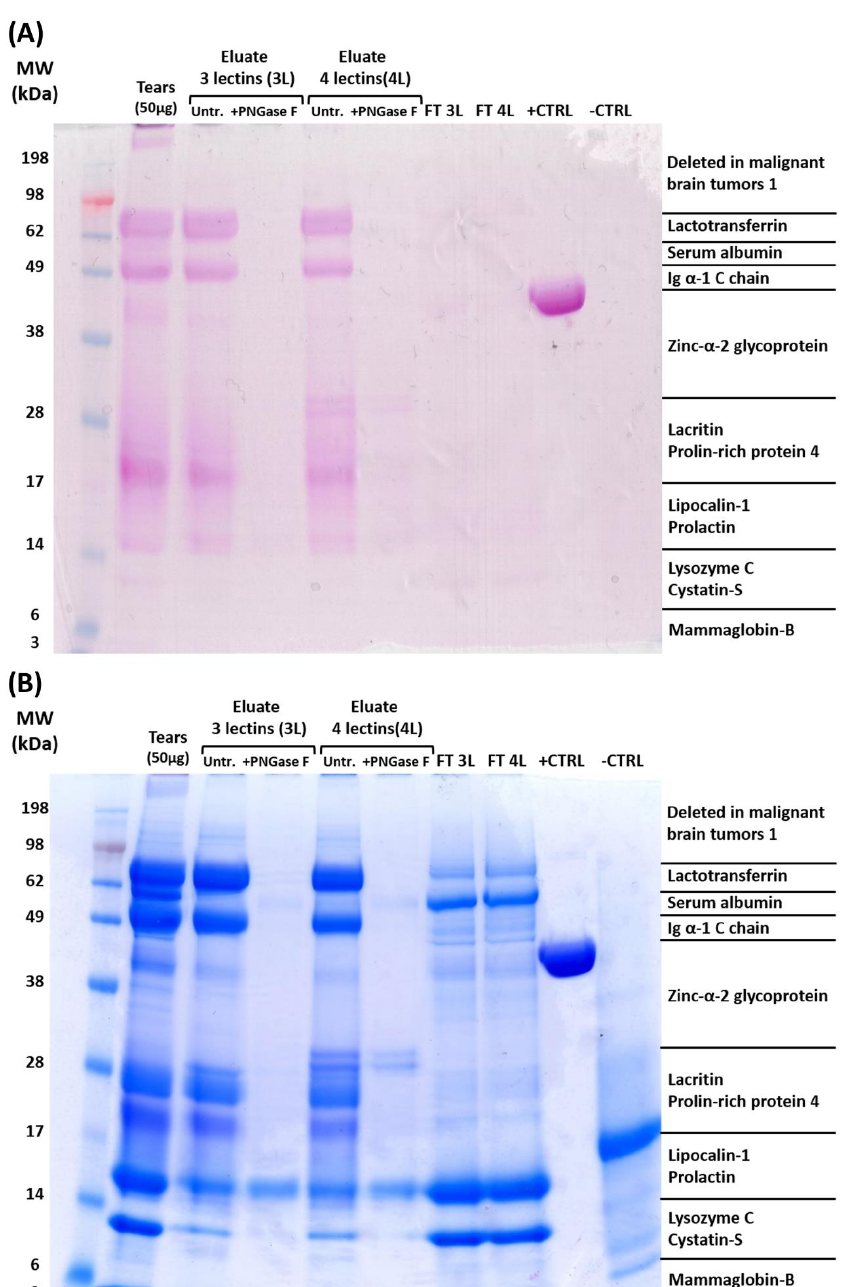
Figure 3. The 1D gel electrophoresis and glycoprotein/Coomassie staining of enriched glycoproteins from human tear sample pools. Both images illustrate the eluate as well as the flow-through (FT) fractions of the 3L multi-lectin column (combination of ConA, JAC, and WGA) and the 4L multi- lectin column system (combination of ConA, JAC, WGA, and UEA I). Prior to affinity enrichment, the tear sample pools were partially pre-treated with PNGase F to release the N-glycans from the glycoproteins. An untreated tear sample pool (50 µ g) was also included to match the enriched glycoprotein spots with the native tear film proteome. In addition, a glycosylated protein stan- dard (horseradish peroxidase, +CTRL), as well as a non-glycosylated protein standard (soybean trypsin inhibitor, -CTRL), were either included as a positive or negative control in this experiment. ( A ) Glycoprotein staining of the 1D gel which specifically colored the glycan motifs of the tear film glycoproteins/protein standards as magenta stained protein bands. ( B ) Coomassie protein staining of the 1D gel to visualize all the proteins as brilliant blue protein bands. The most abundant protein markers were labeled in the respective mass